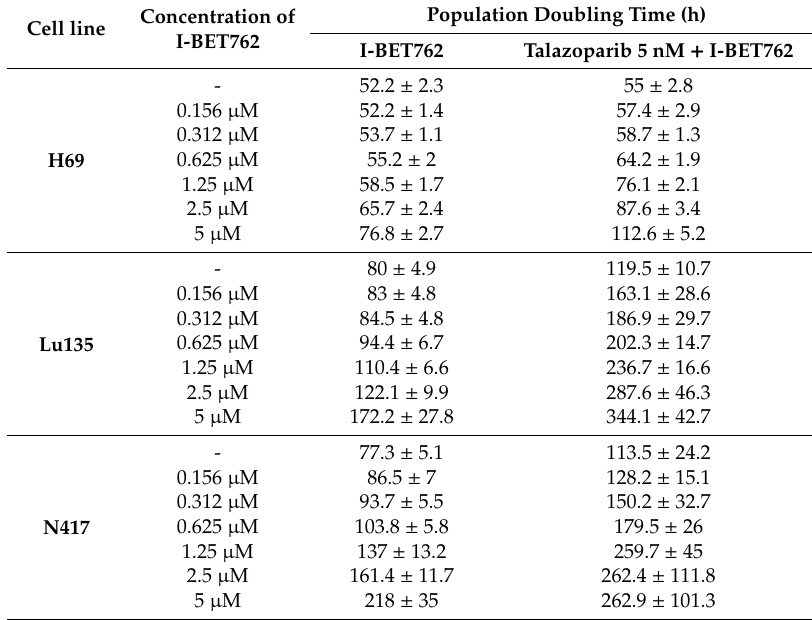
Figure 3. Efficacy of I-BET762 and Talazoparib on long-term growth of SCLC cells. ( A ) Timeplot of H69 (A), Lu135 (B), or N417 (C) spheroid volumes treated with Talazoparib (5 nM) or I-BET762 (0.156 µM, 0.312 µM, 0.625 µM, 1.25 µM, 2.5 µM or 5 µM) as single agents or as a combination. Values shown are mean ± sd of 12 replicates. ( B ) Volumes of treated spheroids after 14 days of treatment normalized to volumes in untreated spheroids at indicated concentrations. Volumes of Talazoparib-treated spheroids is shown as red dashed lines. ( C ) Bliss Independence Combination Index at each concentration of I-BET762 combined with Talazoparib 5 nM after 14 days of treatment. Table 3. Population doubling time (PDT) of SCLC cells. Values are mean ± sd after 14 days of treatment with indicated I-BET762 and/or Talazoparib concentrations. Values are mean ± sd for twelve replicates per treatment.